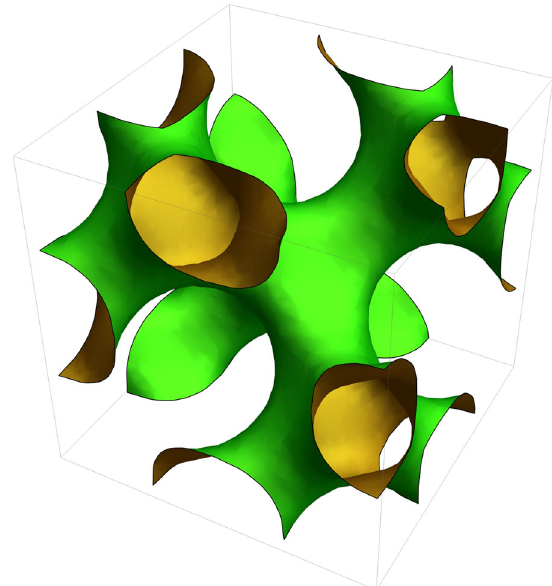
Fig. 3 The KS turning surface of Si at mild expansion. The surface shows the CAR (outside, green) and CFR (inside, yellow) for silicon at 1.30 a , with a the equilibrium cubic lattice constant. Both regions are simultaneously fully connected.